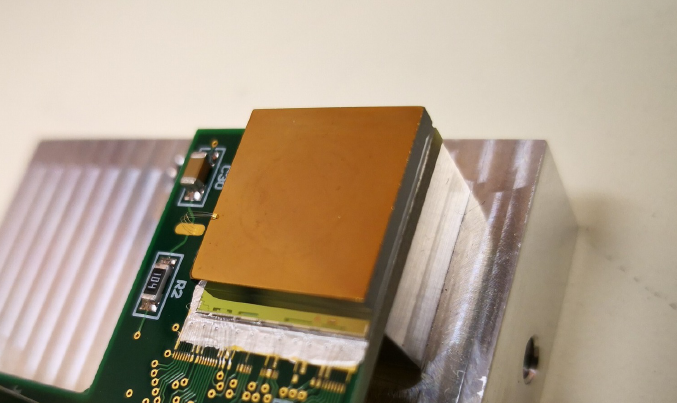
Figure 2. A photograph showing a CdZnTe sensor bump-bonded on a Timepix chip. The hybrid structure is mounted on custom-designed printed circuit